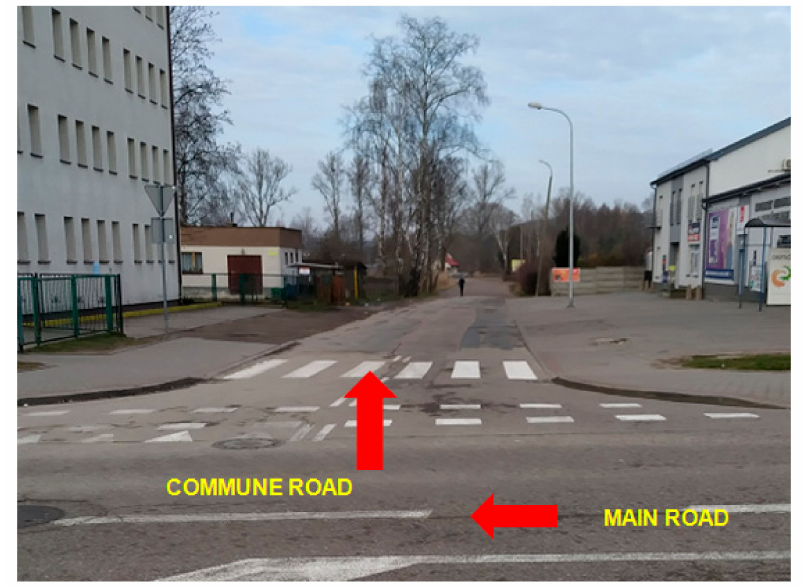
Figure 3. The current solution of connecting the main road with the commune